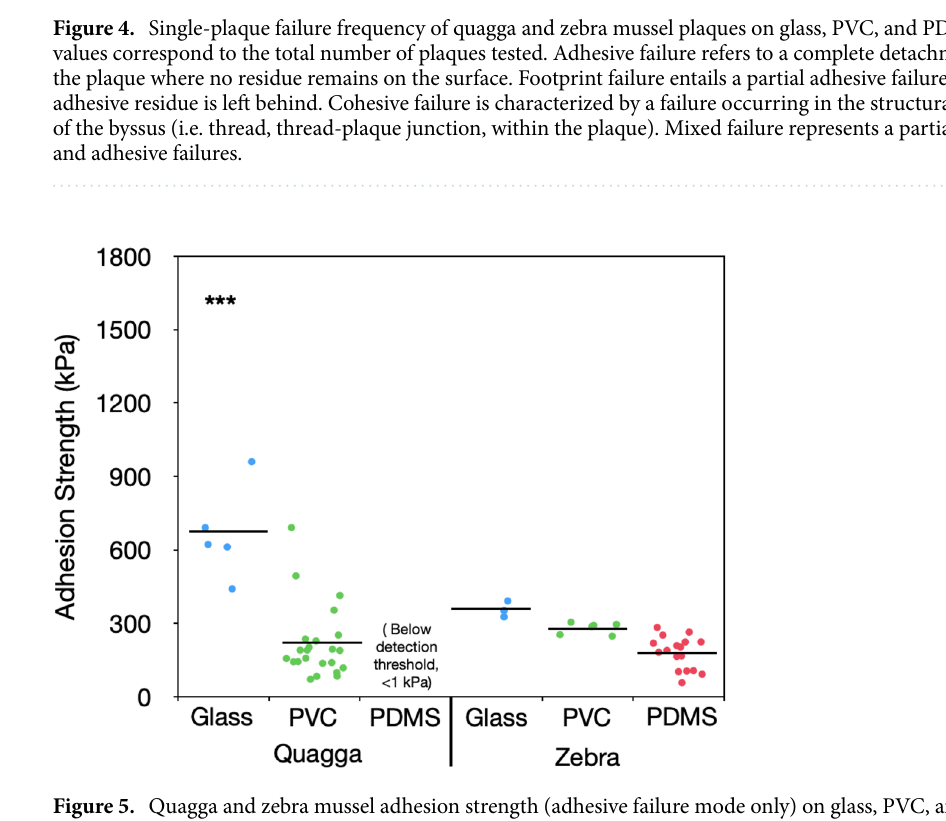
Figure 5. Quagga and zebra mussel adhesion strength (adhesive failure mode only) on glass, PVC, and PDMS. *** denotes p ≤